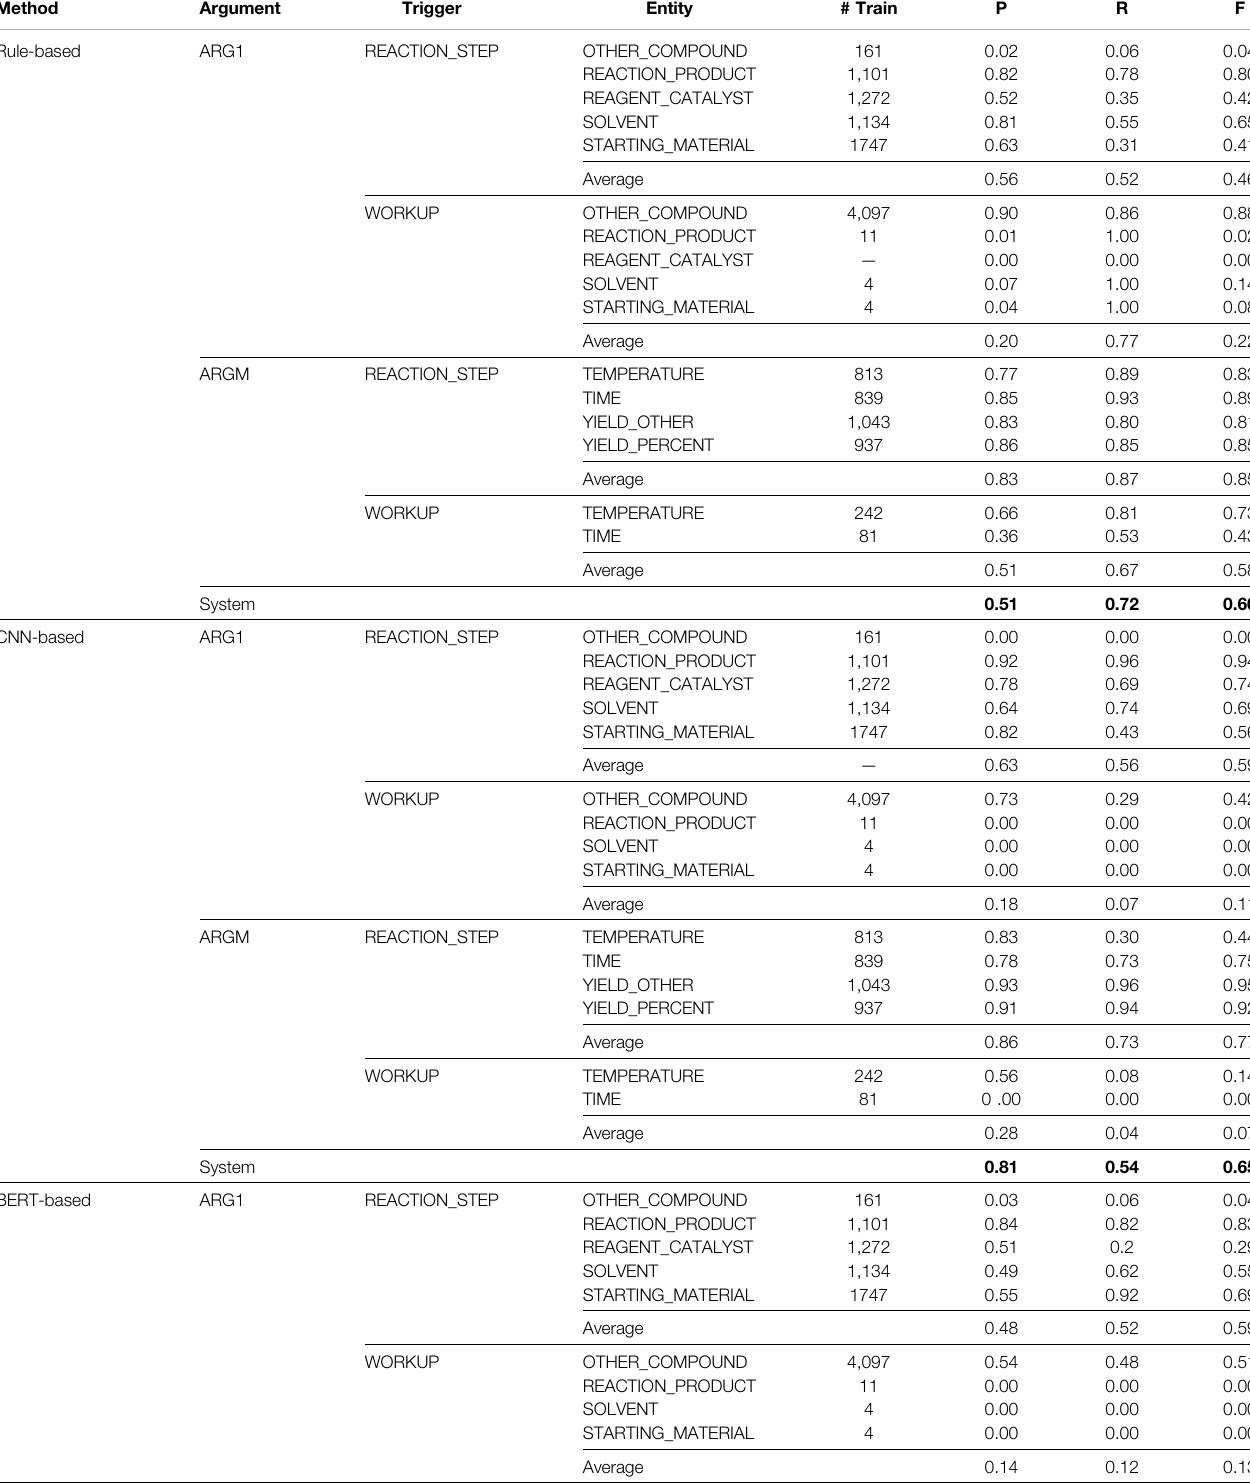
TABLE 5 | Precision (P), recall (R), and F 1 (F) score of the EE system with trigger words identi fi ed using our BiLSTM + CRF trained with ChEMU patent